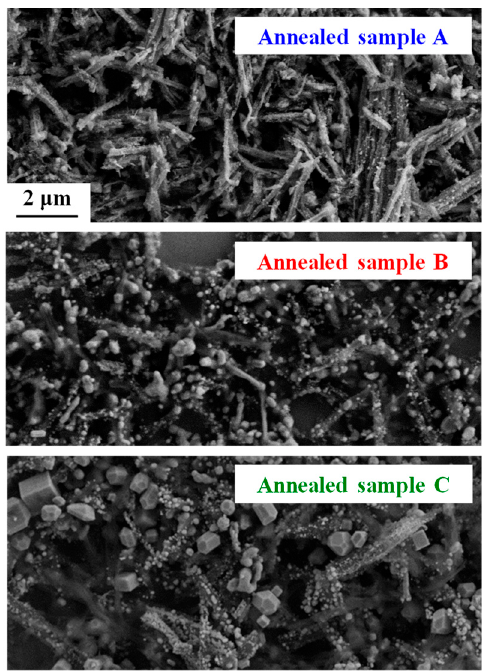
Figure 2. X-ray diffraction (XRD) patterns at various temperatures in N 2 -5% H 2 atmosphere. Reference diffraction patterns for bcc Fe, FeO, Fe 3 O 4 and γ -Fe 2 O 3 are also given. Arrows in Figure indicate diffraction peaks due to sample holder.